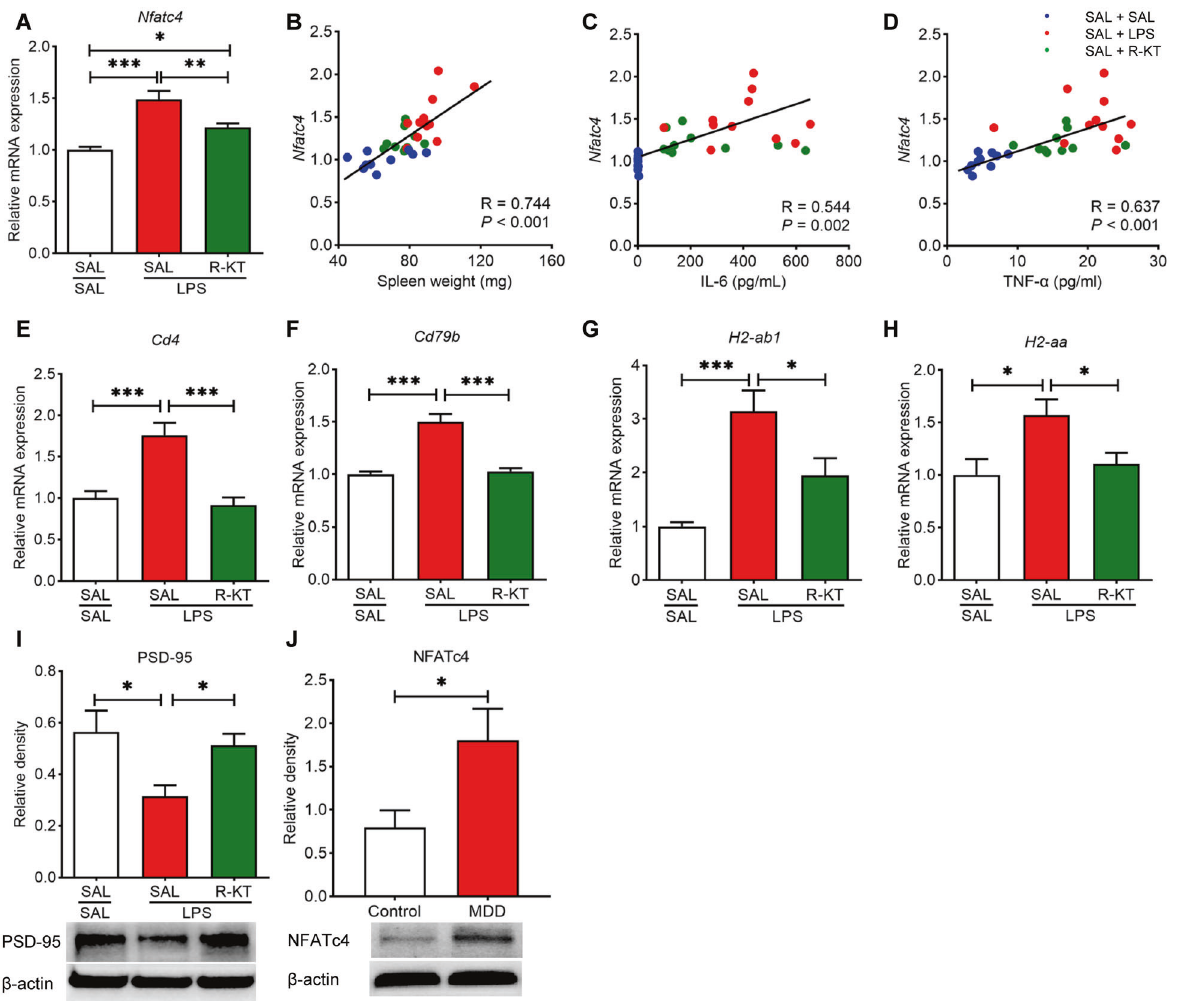
Fig. 3 Prophylactic effects of ( R )-ketamine on the expression of NFATc4 in the PFC after LPS injection. A Nfatc4 mRNA in the PFC (one way ANOVA: F 2,28 = 17.84, P < 0.0001). B There was a positive correlation ( R = 0.744, P < 0.0001) between spleen weight and Nfatc4 mRNA in the PFC. C There was a positive correlation ( R = 0.544, P = 0.002) between plasma interleukin (IL)-6 and Nfatc4 mRNA in the PFC. D There was a positive correlation ( R = 0.637, P < 0.0001) between plasma tumor necrosis factor (TNF)- α and Nfatc4 mRNA in the PFC. E Cd4 mRNA in the PFC (one way ANOVA: F 2,28 = 16.16, P < 0.0001). F Cd79b mRNA in the PFC (one way ANOVA: F 2,28 = 30.40, P < 0.0001). G H2-ab1 mRNA in the PFC (one way ANOVA: F 2,28 = 12.81, P = 0.0001). H H2-aa mRNA in the PFC (one way ANOVA: F 2,28 = 5.617, P = 0.009). I The protein expression of PSD-95 in the PFC (one way ANOVA: F 2,27 = 5.506, P = 0.010). The data represent mean ± S.E.M. ( n = 9 – 11). * P < 0.05, ** P < 0.01, *** P < 0.001. J The protein expression of NFATc4 in the parietal cortex from controls ( n = 15) and MDD patients ( n = 15) (Man – Whitney U-test: U = 60.00, P = 0.030). The data represent mean ± S.E.M. ( n = 15). * P <